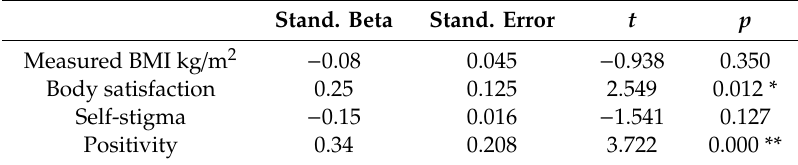
Table 3. Hierarchical multiple regression of happiness on body satisfaction, self-stigma, and positivity controlling for BMI, age, and gender / sex. Stand. Beta Stand.